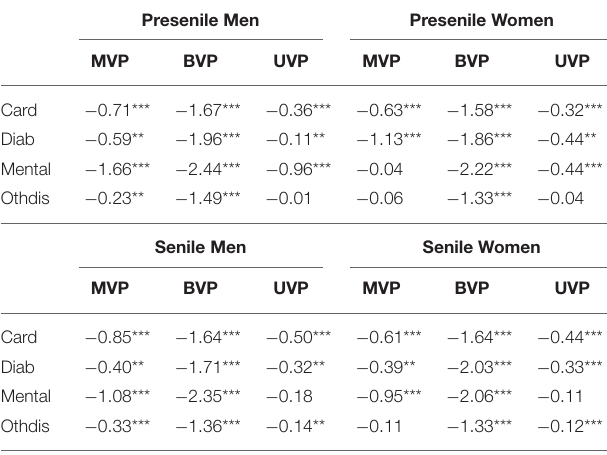
TABLE 5 | Estimated coefficients comparation of probit